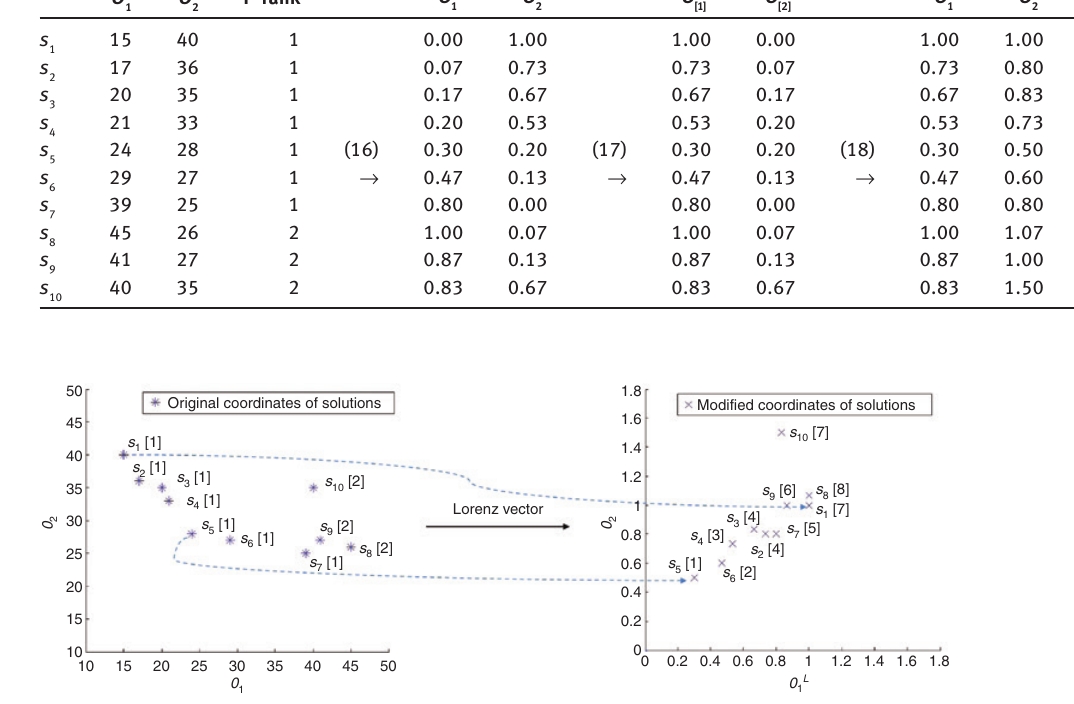
Figure 7: Numerical Example – Creation of the Lorenz Vectors from Original Solution